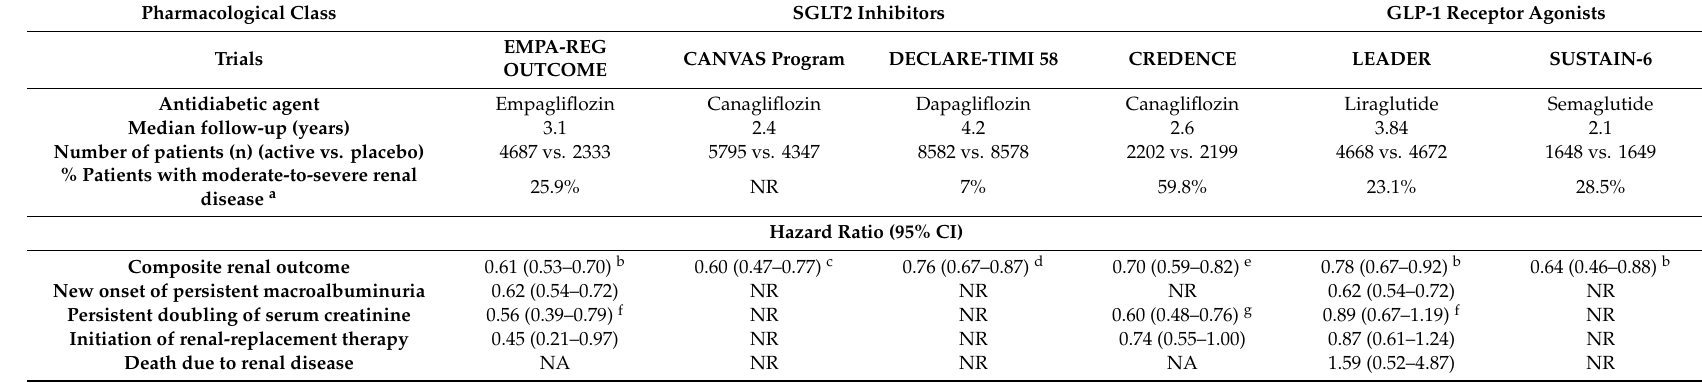
Table 1. Summary of renal outcomes in controlled randomized trials with sodium-glucose co-transporter 2 (SGLT2) inhibitors and glucagon-like peptide-1 (GLP 1) receptor